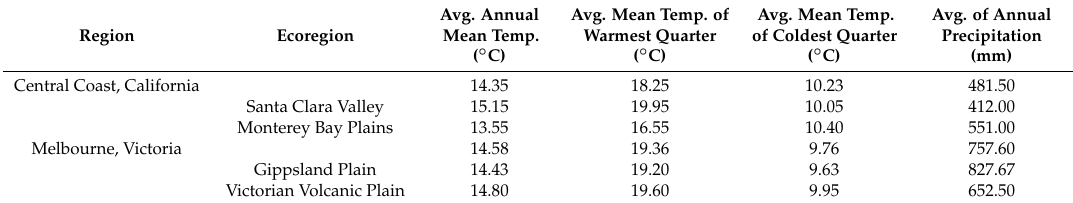
Table 1. Climate variables from WorldClim v2 Bioclim data for regions and ecoregions in which the gardens were located to show the relative similarity in annual temperatures between regions [29]. Bioclim (v2) data are spatially-explicit data calculated over a 1970–2000 baseline period and represent long-term average data. All temperatures are in degrees Celsius. A quarter is 1 calendar year.